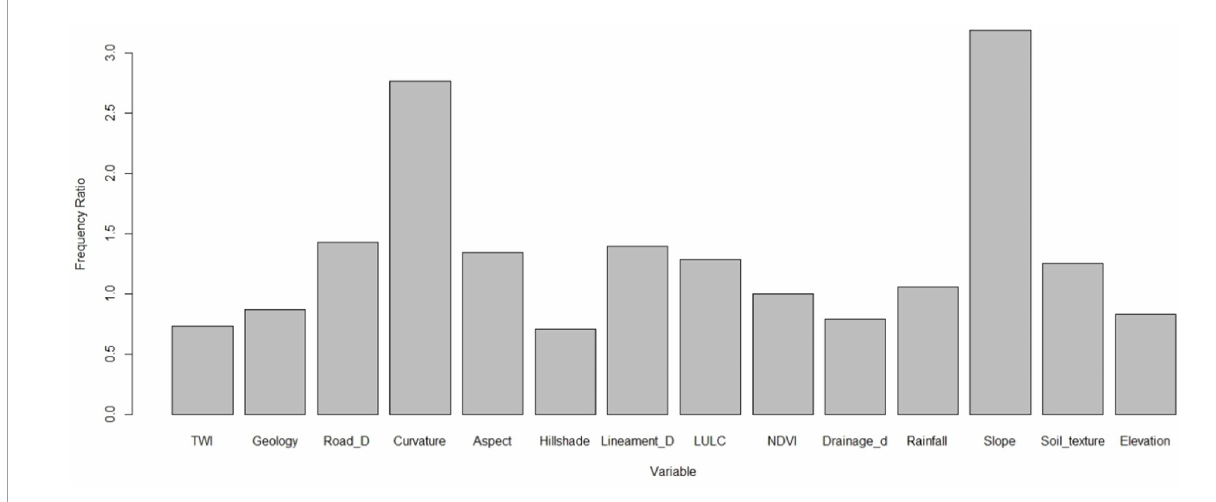
FIGURE5 The variable importance for triggering landslide using frequency ratio.